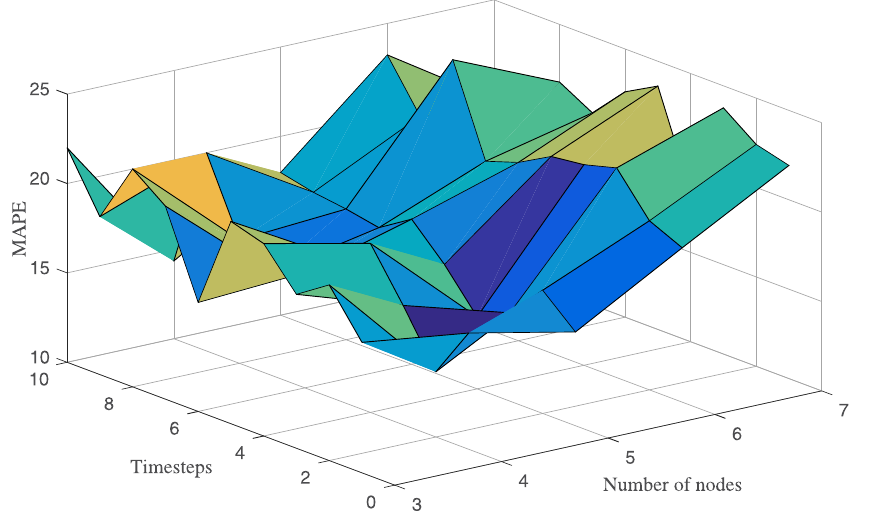
Fig 5. Influence of the nodes number and timestep on performance of LSTM